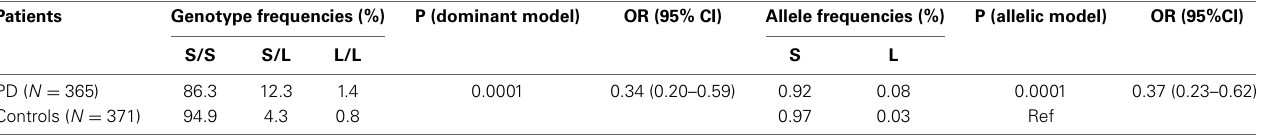
Table 4 | Genotype and allele frequencies for (GT) n repeat polymorphisms in PD patients and healthy subjects.